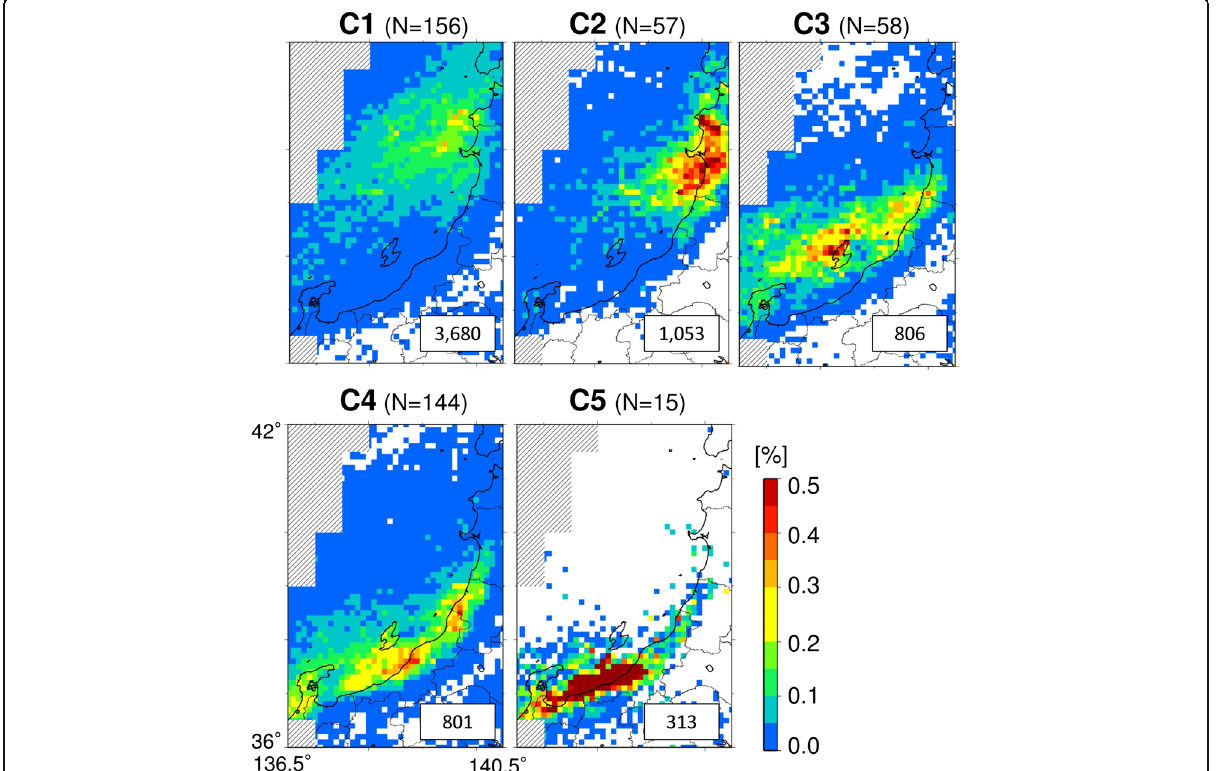
Fig. 5 Lightning frequency distributions for five clusters ( C1 , C2 , C3 , C4 , C5 ). N represents the number of WL cases in each cluster